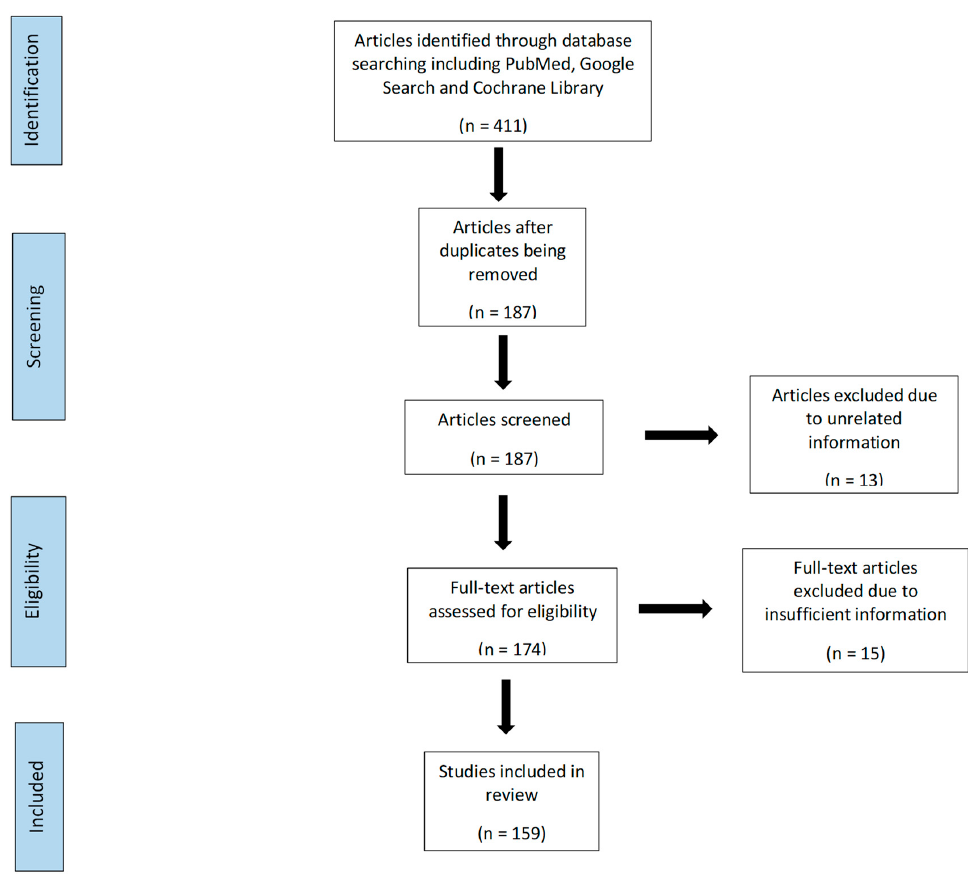
Figure 1. Flow diagram showing the article selection process.